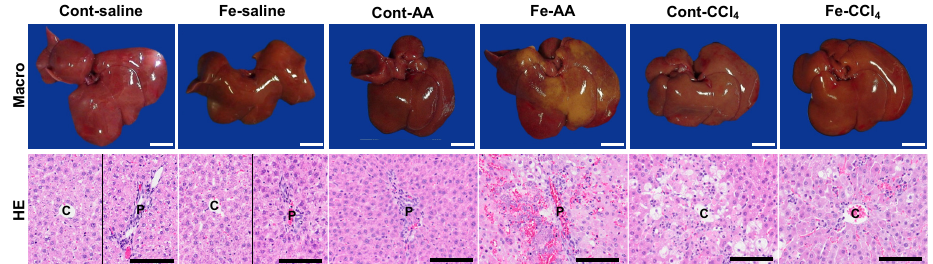
Figure 3. Macroscopic (upper) and hematoxylin and eosin (HE; lower) images of the liver at 24 h after administration of saline, AA, or CCl 4 . Macroscopically, extensive discoloration, corresponding extensive necrosis in HE, is seen in multiple lobules of Fe-AA group. Diffuse discoloration, consistent with centrilobular necrosis, was seen in Cont-CCl 4 group; the microscopic lesion is less prominent in Fe-CCl 4 group. C, centrilobular area; P, portal area. Bar = 1 cm (upper) and 100 µm (lower).